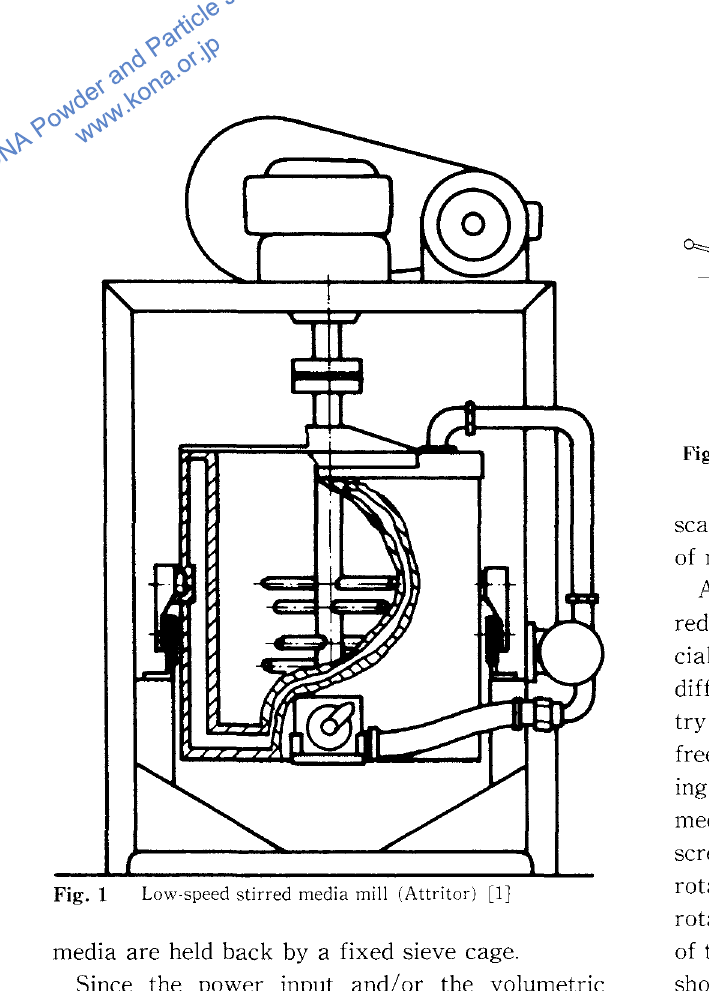
Fig. 1 Low-speed stirred media mill (Attritor) [1] media are held back by a fixed sieve cage.